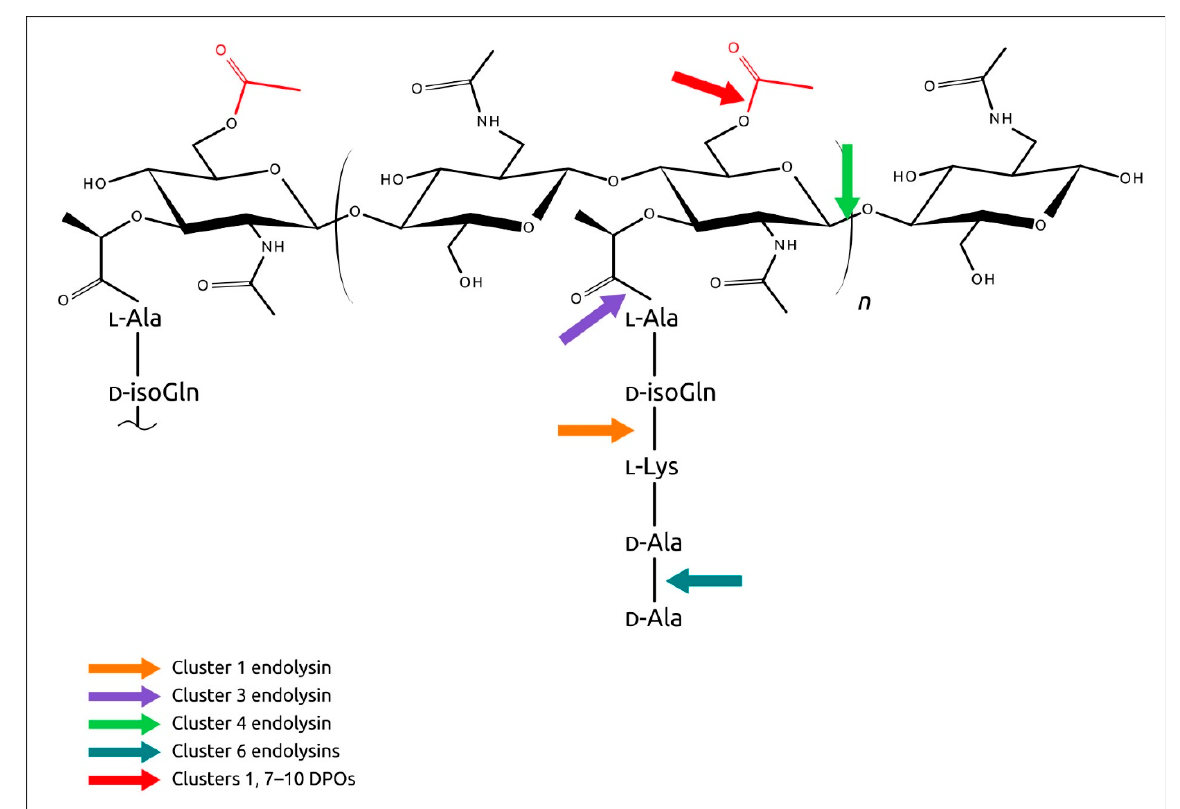
Figure 11. Possible sites for peptidoglycan cleavage, as predicted by cell-wall-degrading enzymes, indicated here with coloured arrows. The O-acetylation of the C-6 OH groups of MurNAc residues is indicated in